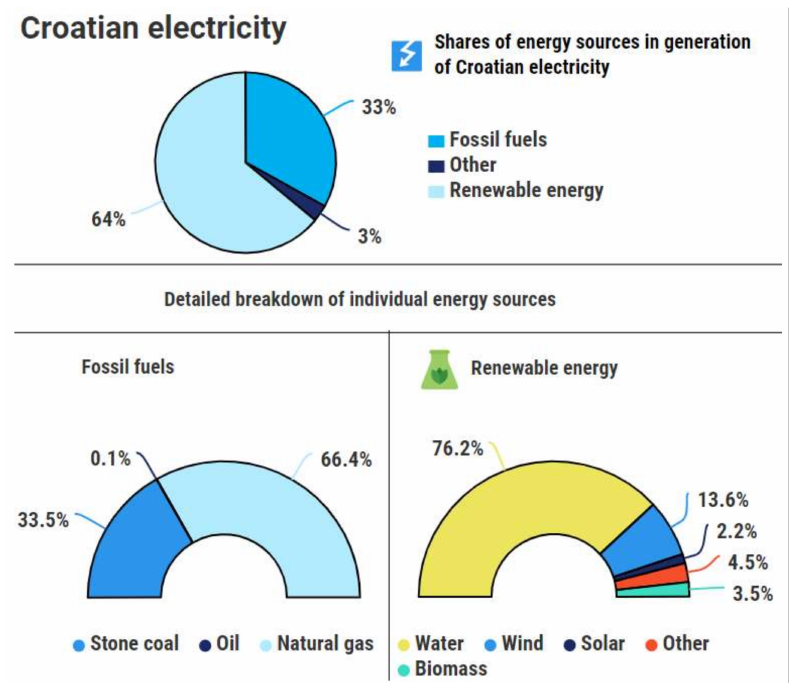
Figure 10. The Croatian electricity